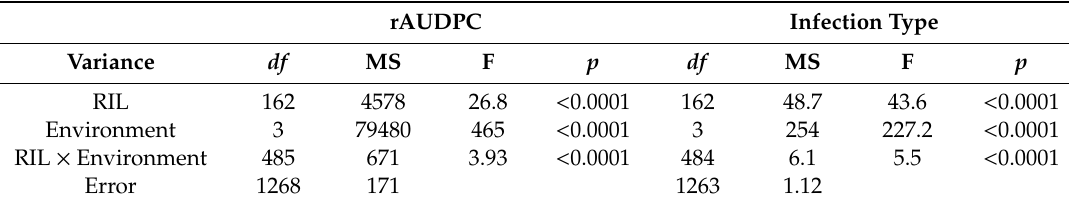
Figure 2. The distribution of relative area under the disease progress curve (rAUDPC) among recombinant inbred lines (RILs) derived from the cross AvS × PI 181410 in the field tests in Pullman and Mount Vernon, WA in 2015, 2016, and / or 2017. Table 2. Analysis of variance (ANOVA) for relative area under the disease progress curve (rAUDPC) and infection type data for a recombinant inbred line (RIL) population derived from cross AvS × PI 181410 in different field environments of Pullman and Mount Vernon, WA in 2015, 2016, and/or 2017. rAUDPC